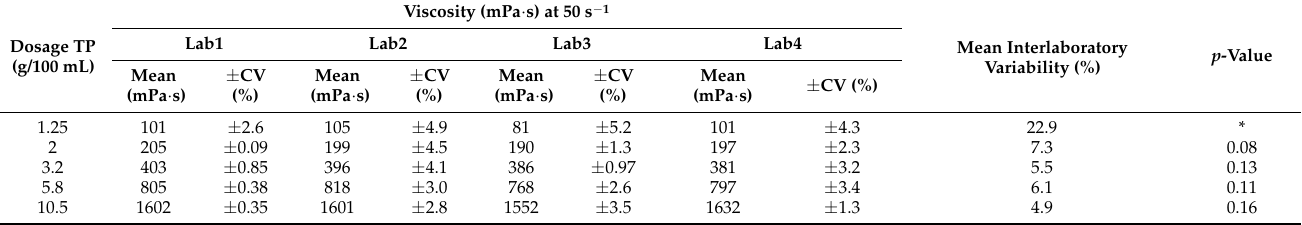
Table 4. Mean values and the coefficient of variation from the triplicates of each viscosity level performed by the four labs. Variations within measurements in the same facility are shown as well as variations between facilities for each viscosity level; * p <